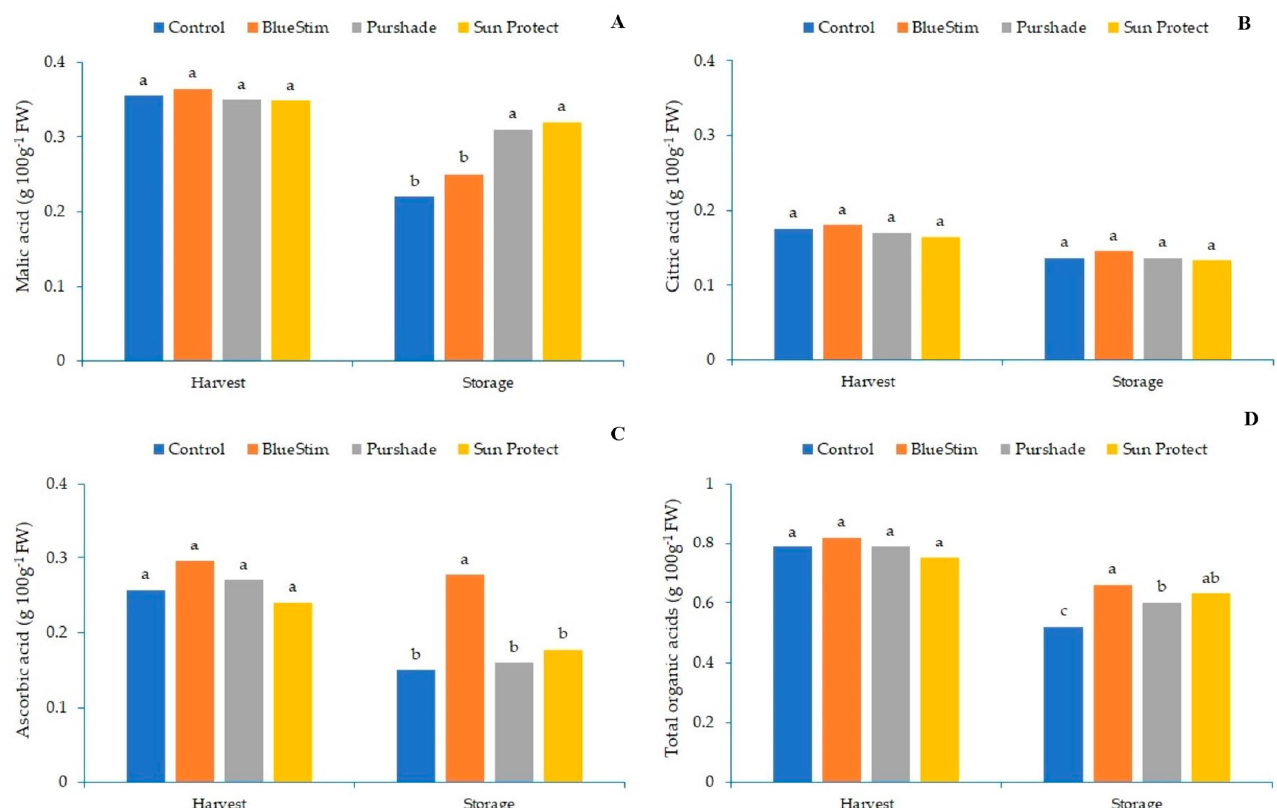
Figure 2. Effect of alleviating products on kiwifruit organic acids concentration (( A ), malic acid, ( B ), citric acid, ( C ), ascorbic acid and ( D ), total organic acids) at harvest and after storage at 0.5 ◦ C for 107 days. Treatment columns with the same lower case letter above, within the same production event (harvest or storage), do not significantly differ according to Tukey’s HSD multiple range test at α = 0.05.